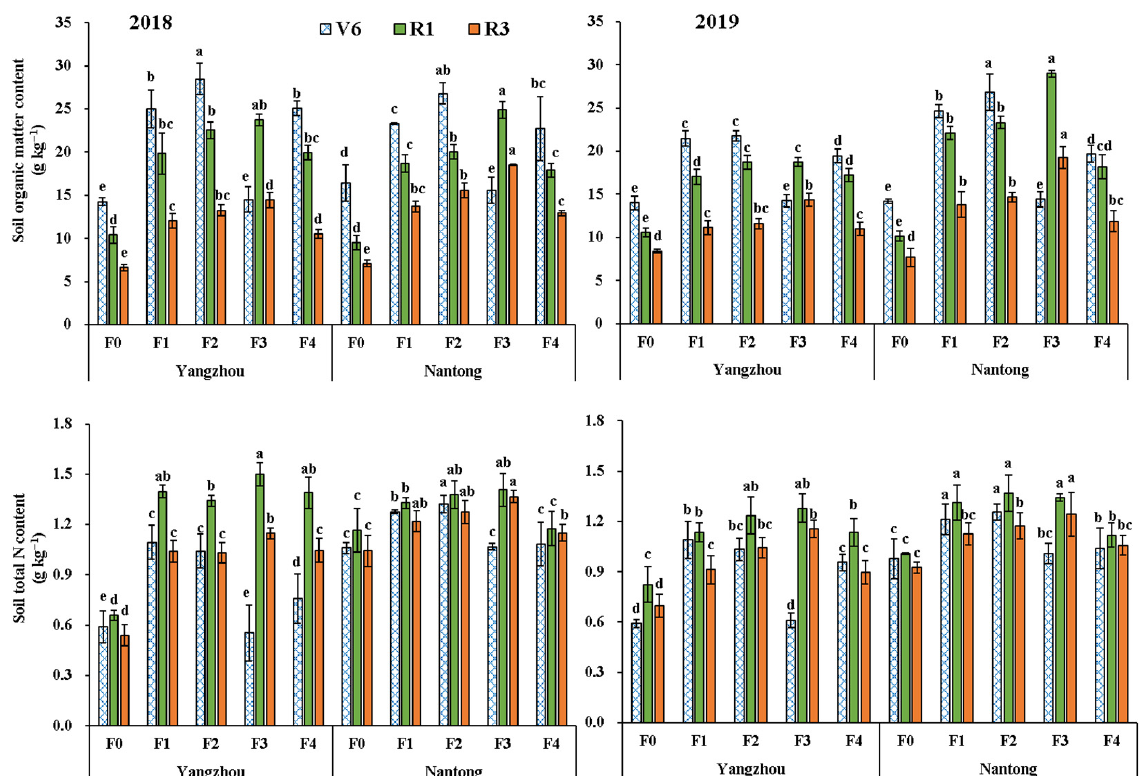
Figure 3. Effects of optimized fertilization practices on organic matter and total N content of rhizo- sphere soil. Vertical bars are means ± standard deviation ( n = 9, from 3 independent plots). Different letters above the bars represent significant differences at p < 0.05 at same stage. Note: F0: no fertilizer; F1, F2, and F3 represent new compound fertilizer applied 225 kg N ha − 1 at sowing, V3, and V6 stages, respectively; F4: applied 75 kg N ha − 1 traditional compound fertilizer at sowing stage and 150 kg N ha − 1 urea at V6 stage. V6, R1, and R3 represent six-leaf, silking, and milking stages, respectively.